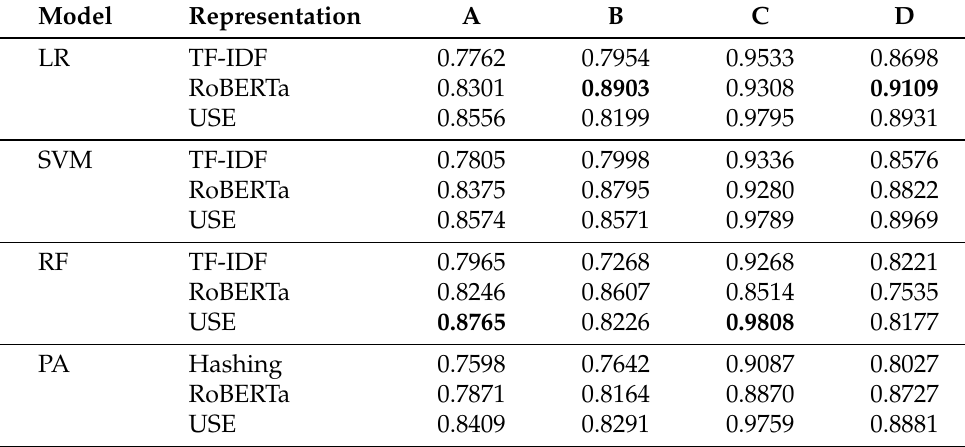
Table A1. Classification performance of the models trained on the initialization set. Best score for each dataset is shown in bold. A–D correspond to the four datasets we used to conduct the experiments, which are described in Table